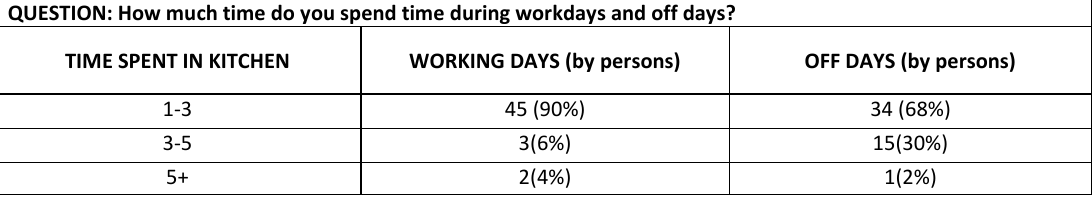
Table 2 Distribution of subjects according to time interval while spending time in